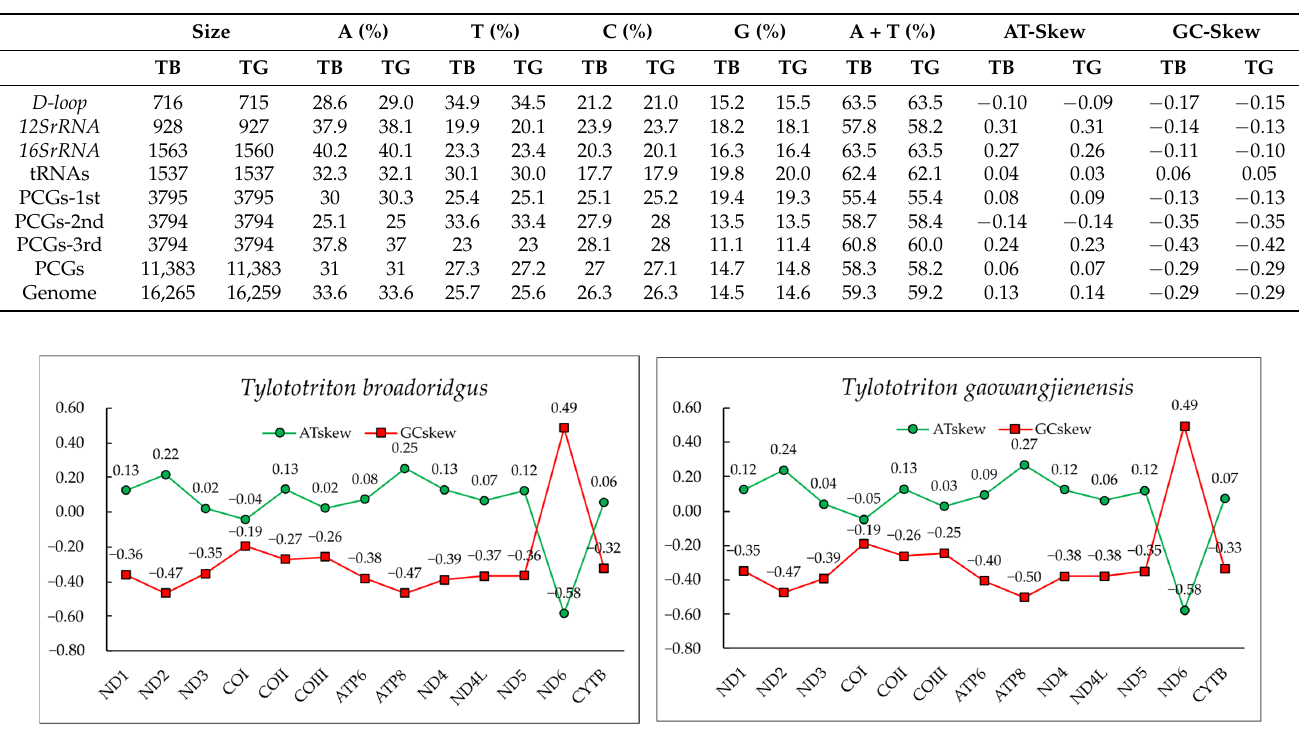
Genes 2022 , 13 , x FOR PEER REVIEW Figure 2. GC and AT skews of mitochondrial PCGs of T. broadoridgus and T. gaowangjienensis .